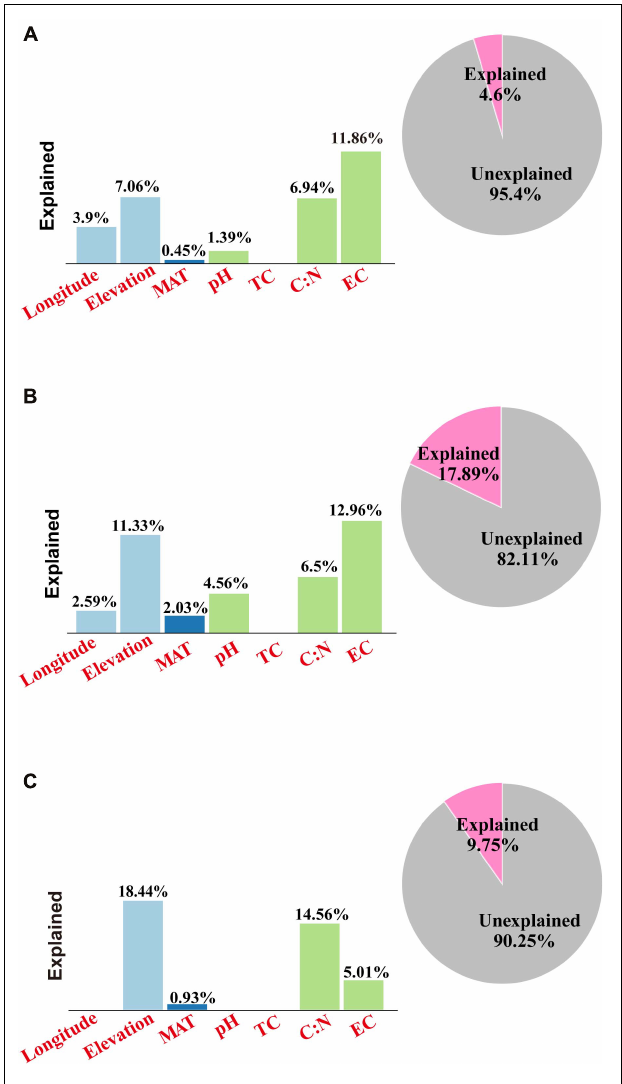
FIGURE 5 | Variation partition analysis (VPA) results for the environmental variables for the soil (A) bacterial, (B) archaeal, and (C) eukaryota communities along the elevational gradient in alpine meadows of the Qilian Mountains. Variables: MAT, mean annual temperature; MAP, mean annual precipitation; EC, electrical conductivity; TC, total carbon; TN, total nitrogen. The “Explained” in bar graphs represent the individual explanation of single environmental variables, whereas the “Explained” in pie graphs represent the whole explanation of all environmental